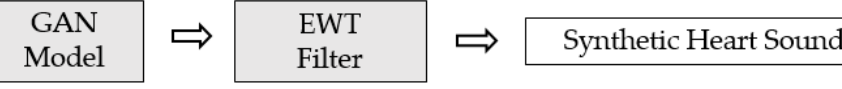
Figure 3. General diagram of proposed method.